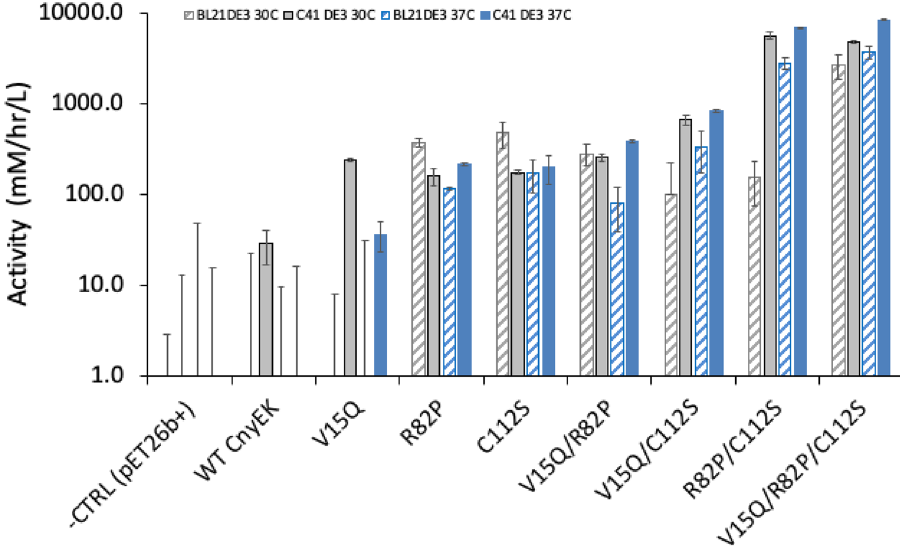
Figure 1. Total activity of EK L variants at 30° or 37 °C in E. coli strains BL21(DE3) or C41(DE3). Cells expressing the pelB-fused Chinese northern yellow Cny-EK L variants were grown at 37 °C or 30 °C for 16–20 h in shallow round-bottom 96-microwell plates, then again after dilution in deep V-bottom 96-microwell plates, for 6 h, induced with IPTG, and incubated for a further 4 h. Cells were pelleted and resuspended in a lysis mixture, then clarified, before assaying for EK L total activity with the GD4K-na fluorogenic substrate at pH 8.4, 25